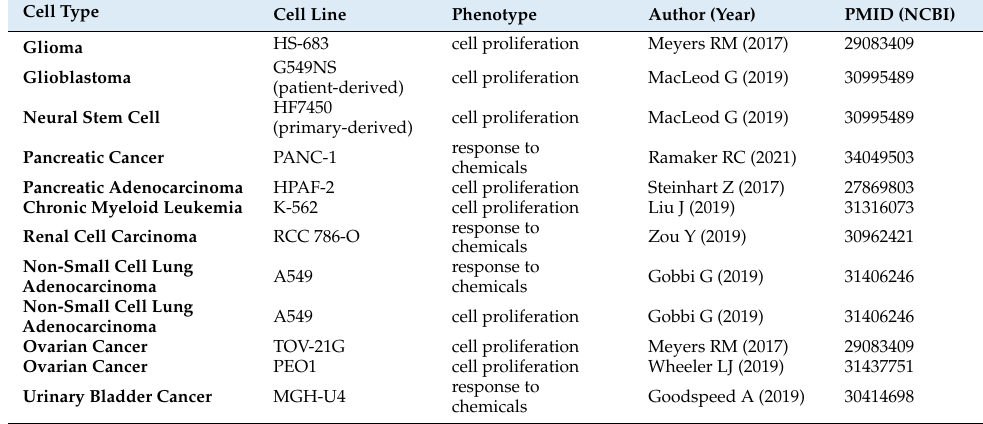
Table 1. CRISPR/CAS9 modulation of VENTX in human from BioGRID Open Repository for CRISPR Screen (ORCS)